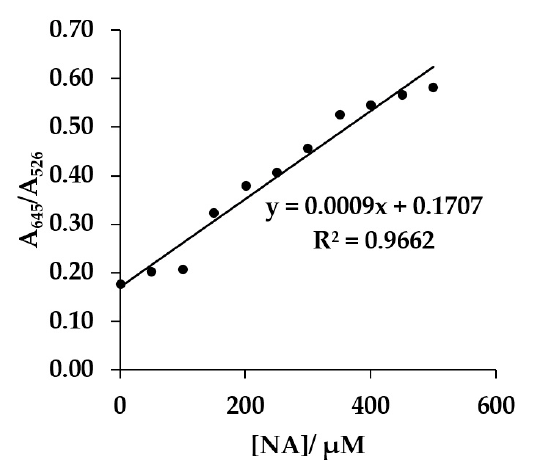
Figure 4. Analysis of NA in wastewater using colloidal gold nanoparticles by the standard addition method.